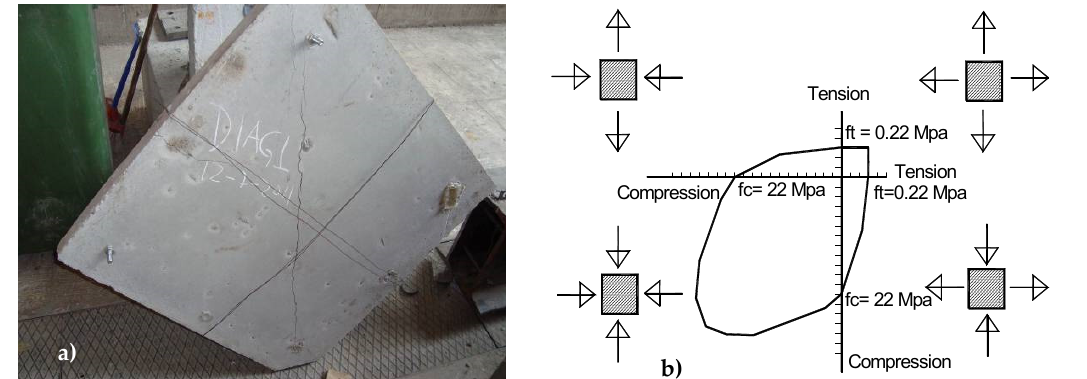
Figure 19. ( a ) Observed damage. ( b ) Numerically simulated diagonal tension cracking of square concrete panel. ( b ) Assumed combined compression–tension failure envelope included in the numerical simulation of the square concrete panel subjected to diagonal compression as well as of RC the infilled panels.